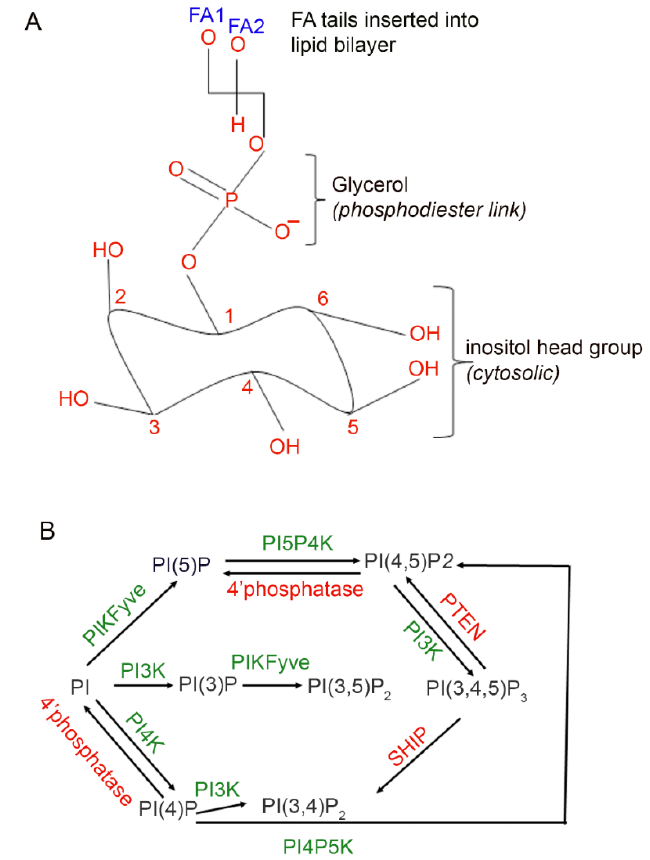
Figure 1. Seven distinct phosphoinositide molecules in the cell. The parent phosphoinositide (PI) contains a myo-inositol head group, and a glycerol backbone, and two fatty acids (FA1 and FA2) are attached to the C1 and C2 position of the glycerol ( A ). The free hydroxyl group, 3, 4, 5 on the inositol ring undergoes phosphorylation by PI kinases (green). Dephosphorylation by PI phosphatases (red) generates seven distinct phosphoinositide second messenger molecules (black) in the cell ( B ). PI, phosphatidylinositol; PI(3)P, phosphatidylinositol 3-phosphate; PI(4)P, phosphatidylinositol 4-phosphate; PI(5)P, phosphatidylinositol 5-phosphate; PI(3,4)P 2 , phosphatidylinositol 3,4-bisphosphate; PI(4,5)P 2 , phosphatidylinositol 4,5-bisphosphate; PI(3,5)P 2 , phosphatidylinositol 3,5-bisphosphate; PI(3,4,5)P 3 , phosphatidylinositol 3,4,5-trisphosphate; PI3K, phosphoinositide 3-kinase; PI4K, phosphoinositide 4-kinase; PI4P5K, phosphatidylinositol 4-phosphate 5-kinase; PI5P4K, phosphatidylinositol 5-phosphate 4-kinase; PTEN, phosphatase and tensin homolog; SHIP, Src homology 2 (SH2) domain-containing inositol polyphosphate 5-phosphatase; PIKfyve, phosphatidylinositol-3-phosphate 5-kinase type III or PIPKIII or FYVE phosphoinositide kinase.